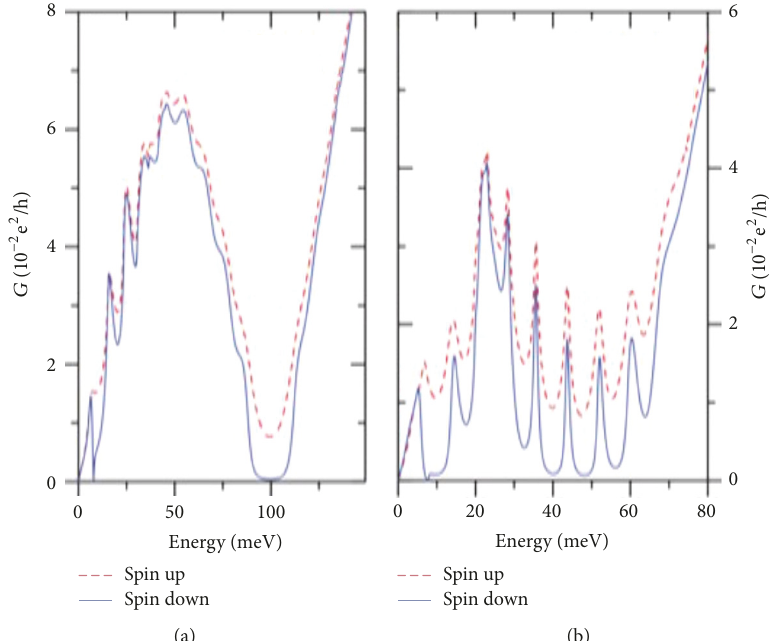
Figure 8: (Color online) (a) Conductance through a single barrier versus energy 𝐸 . The dashed and solid curves are for spin-up ( 𝐺 ↑ , 𝑠 − = 0 ) and spin-down ( 𝐺 ↓ , 𝑠 + ̸= 0 ) electrons, respectively. (b) Conductance through the double barrier of Figures 5–7. The Fermi velocity (energy) is given in the caption of Figure